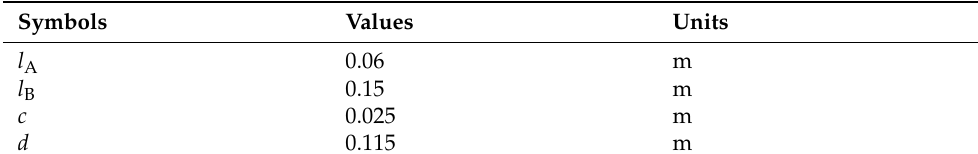
Table 4. Structural parameters of the 2UPR-RPU parallel manipulator.